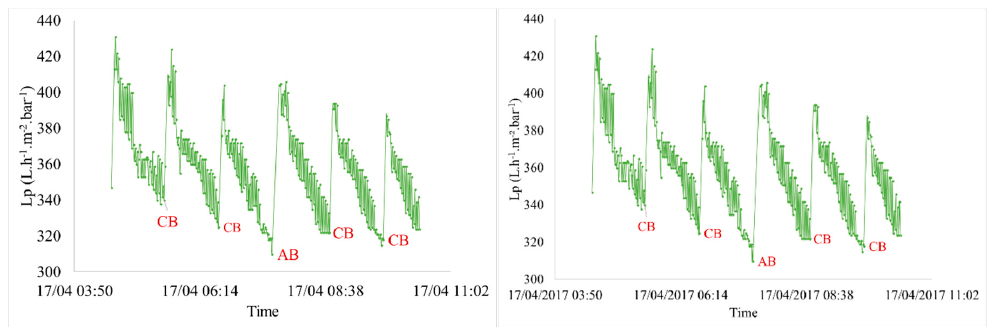
Figure 2. Variation of permeability vs. time (J = 60 L h − 1 m − 2 and t filtration = 60 min for seawater filtration).